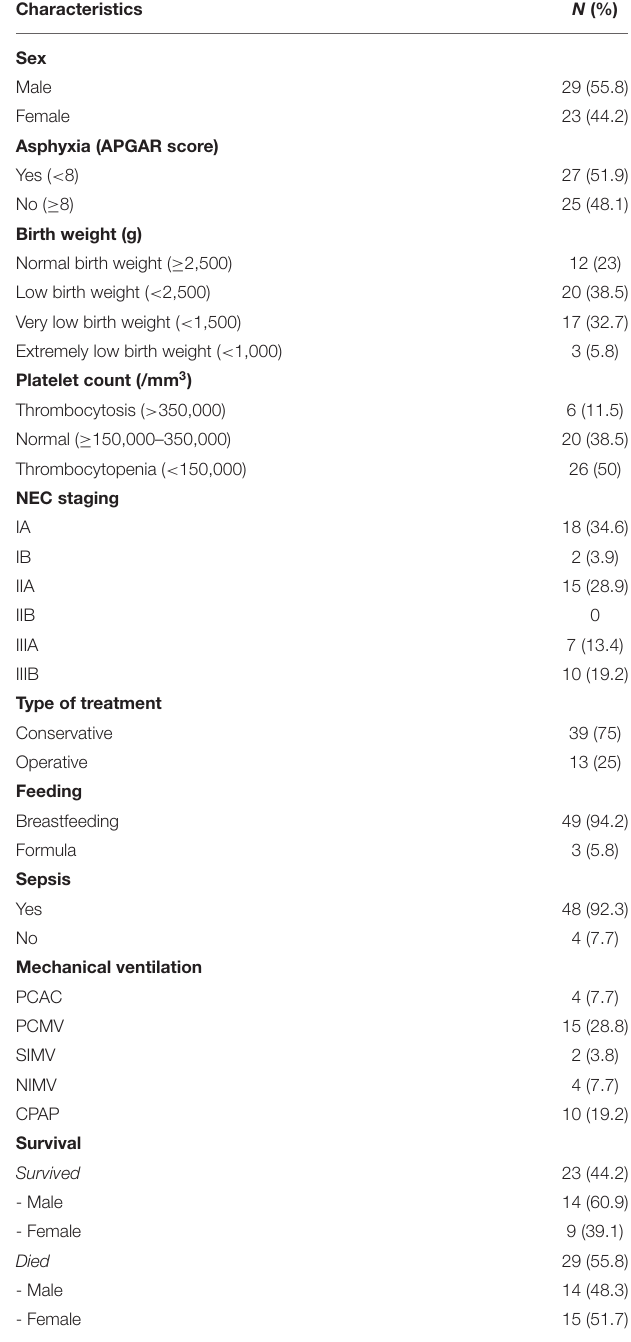
TABLE 1 | Baseline characteristics of neonates with NEC in our institution.